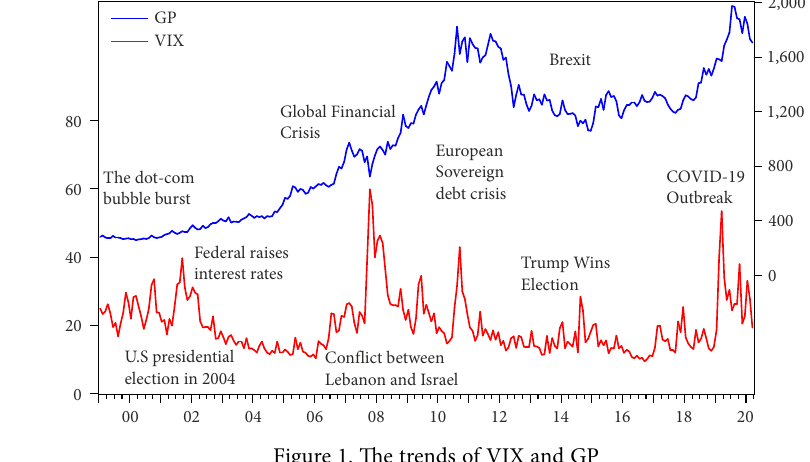
Figure 1. The trends of VIX and